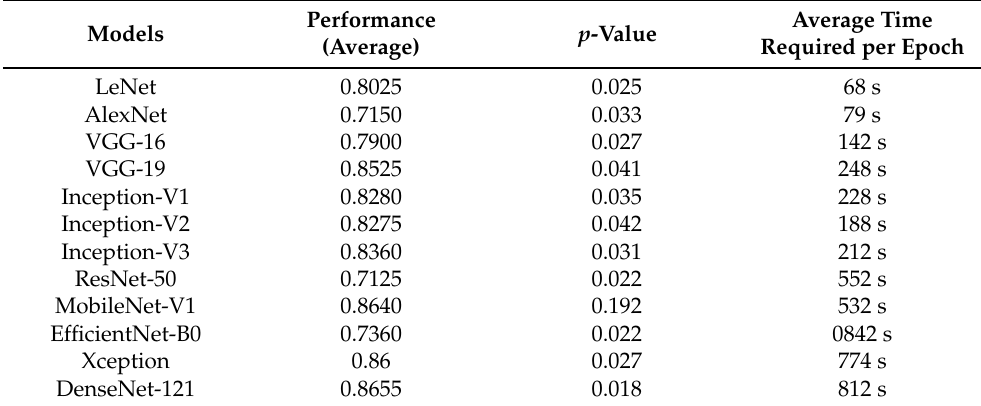
Table 3. Performance comparison of different DNN models for AD